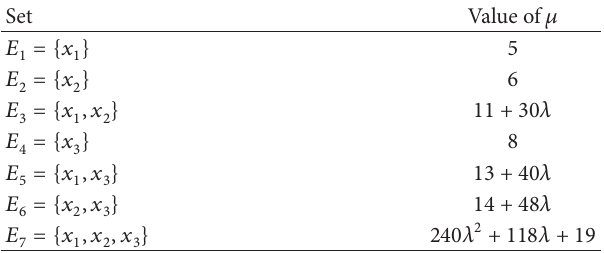
Table 1: The values of set function 𝜇 in Example